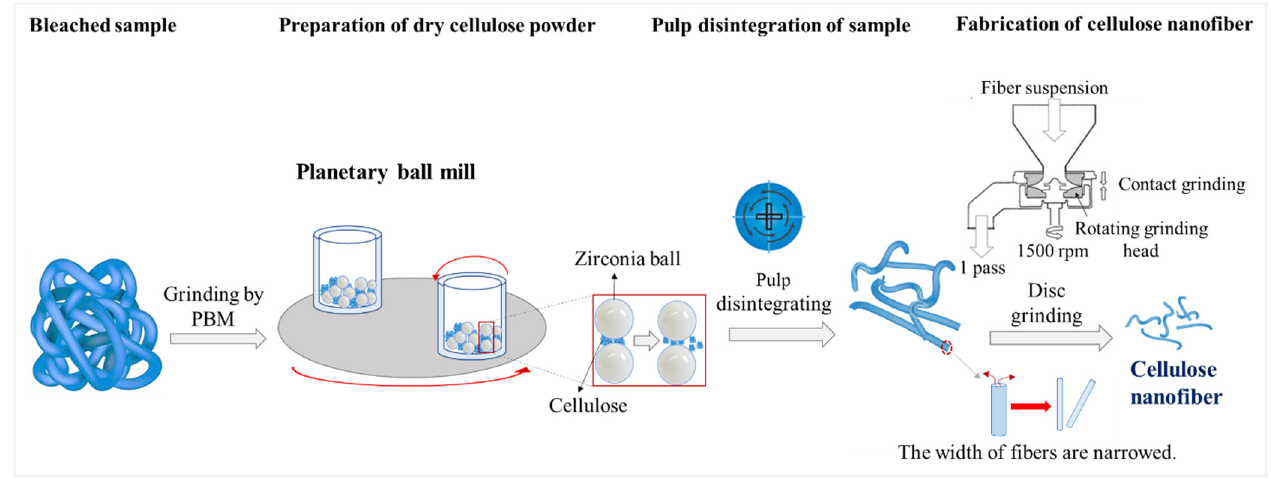
Figure 14. Mechanism of CNF fabrication from dry cellulose powder using a PBM and a disc grinder. Table 3. Comparison of the CNF’s width with average